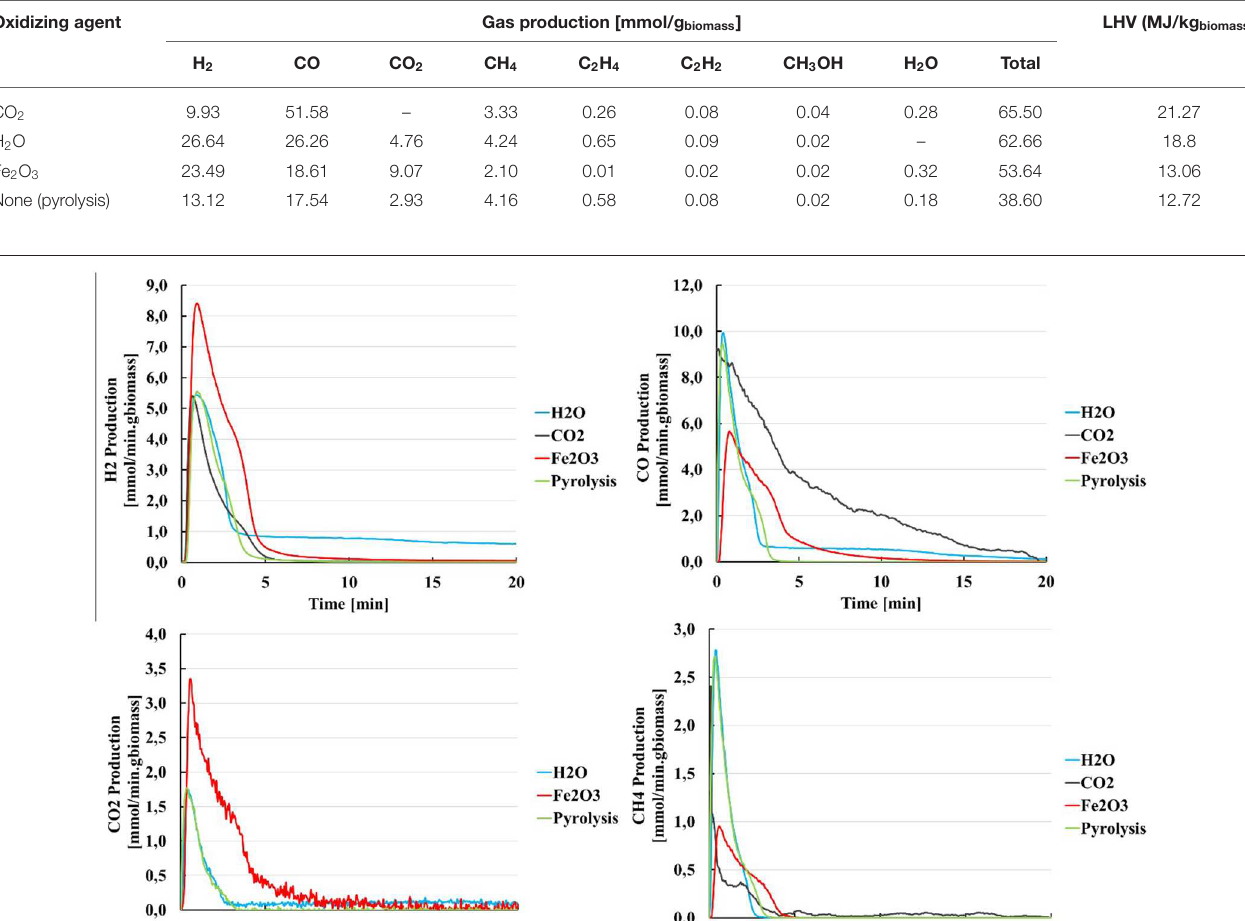
TABLE 2 | Total gas quantities produced during gasification and pyrolysis at 1,100 ◦ C. Oxidizing agent Gas production [mmol/g biomass ]